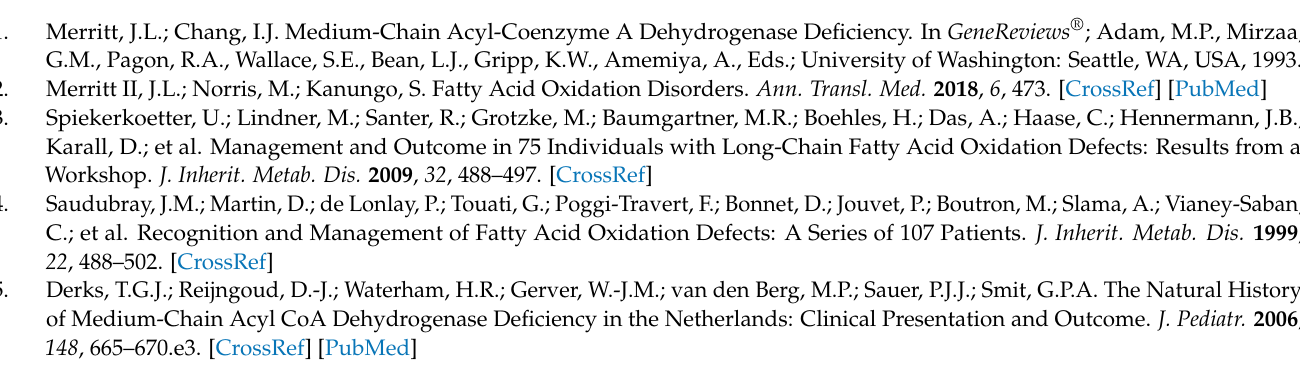
Figure S13: Cumulative meta-analysis: Forest plot: comparison of BMI in MCADD patients vs. controls; Figure S14: Sensitivity meta-analysis: Forest plot: comparison of BMI in MCADD patients vs. controls; Figure S15: Cumulative meta-analysis: Forest plot: comparison of weight in patients with types of FAOD other than MCADD vs. controls; Figure S16: Sensitivity meta-analysis: Forest plot: comparison of weight in patients with types of FAOD other than MCADD vs. controls; Figure S17: Cumulative meta-analysis: Forest plot: comparison of BMI in patients with types of FAOD other than MCADD vs. controls; Figure S18: Sensitivity meta-analysis: Forest plot: comparison of BMI in patients with types of FAOD other than MCADD vs.